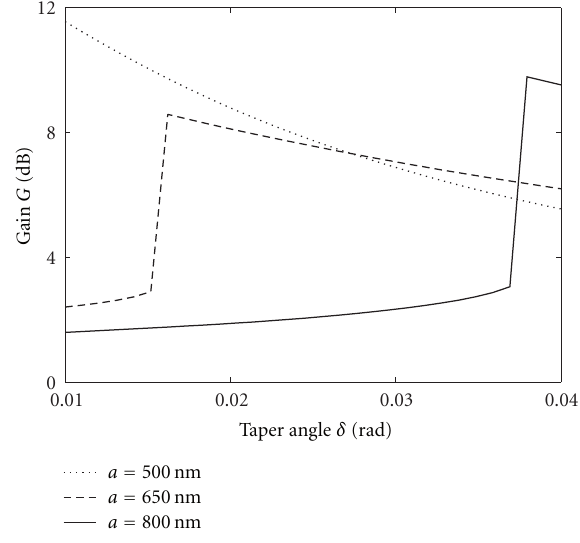
Figure 4: Signal amplification as a function of the taper angle for three di ff erent values of the waist fiber radius.